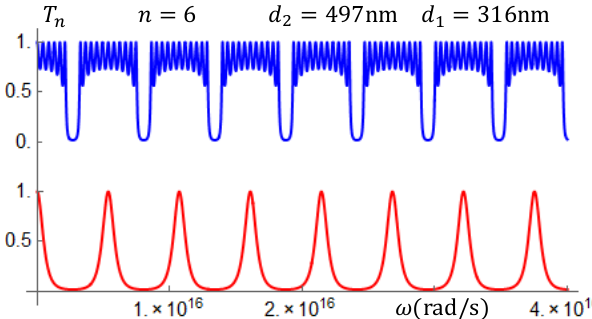
Figure 9. Transmission coefficients (TCs) for the superlattices air ( RR ) 6 air and air ( LR 2 ) 6 air , as functions of the frequency ω , when d L = d 1 = d 2 n 2 / n L = 316.2 nm and d 2 = 497 nm. The TCs of the superlattices air ( LR ) 6 air become a sequence of isolated and equidistant peaks, while the TCs of the superlattices air ( RR ) 6 air become a periodic sequence of resonant bands. This characteristic is independent of the number of unit